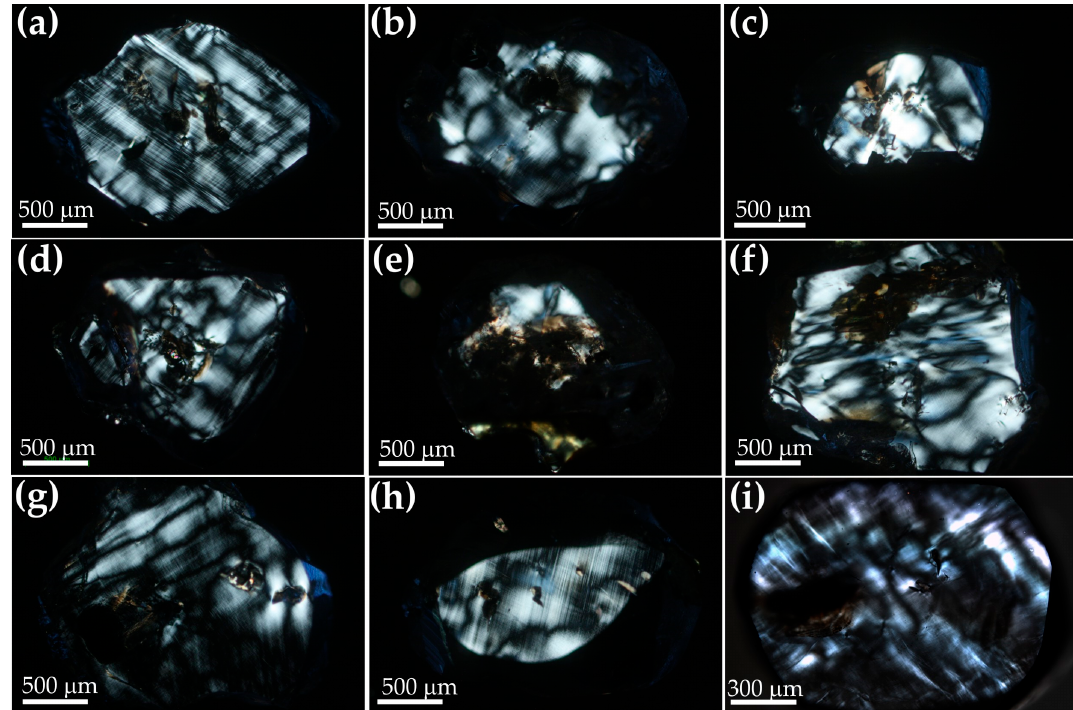
Figure 6. Birefringence patterns of double-polished plates from super-deep diamonds. ( a ) SL-34; ( b ) SL-52; ( c ) SL-55; ( d ) SL-16; ( e ) SL-2; ( f ) SL-24; ( g ) C-2; ( h ) SL-82; ( i ) HH-11. ( a – h ) super-deep diamonds from São-Luiz alluvial placers (Juina, Brazil); (i) super-deep diamond crystal from Kholomolokh placer (northeastern Siberian Platform).